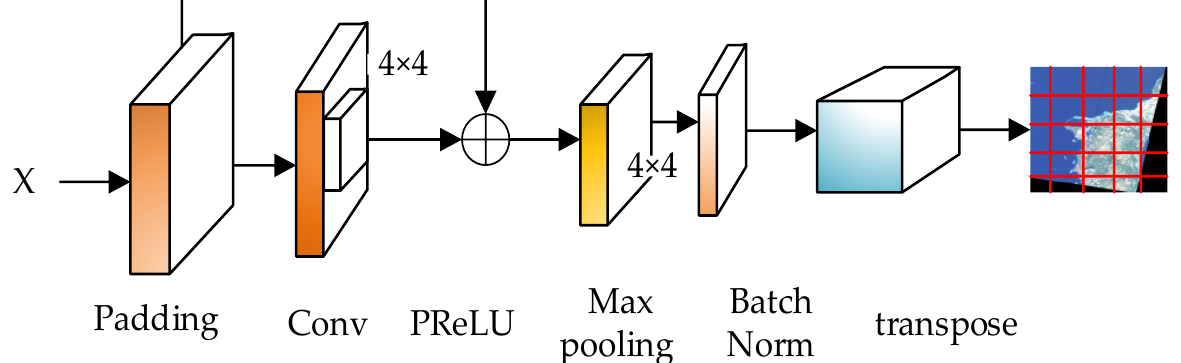
Figure 3. ResNet-like residual network structure.